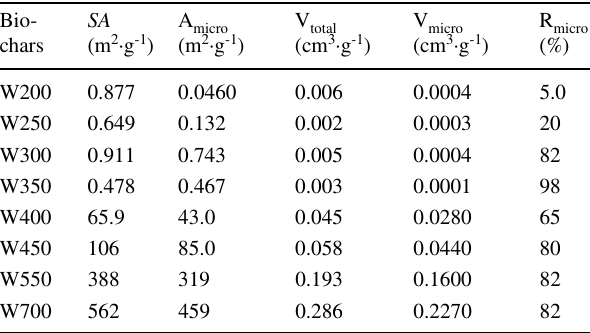
Table 2 Specific surface area and pore properties of biochars